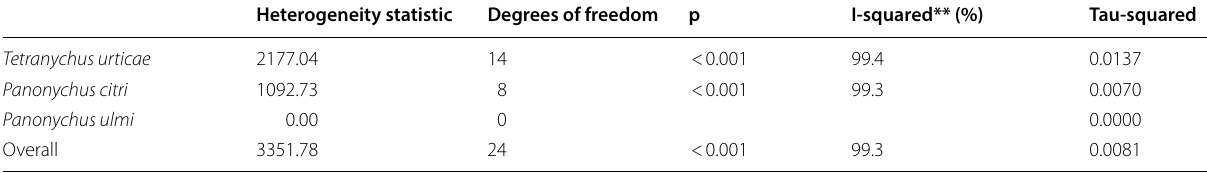
Significance test(s) of prevalence Tetranychus urticae z Panonychus citri z